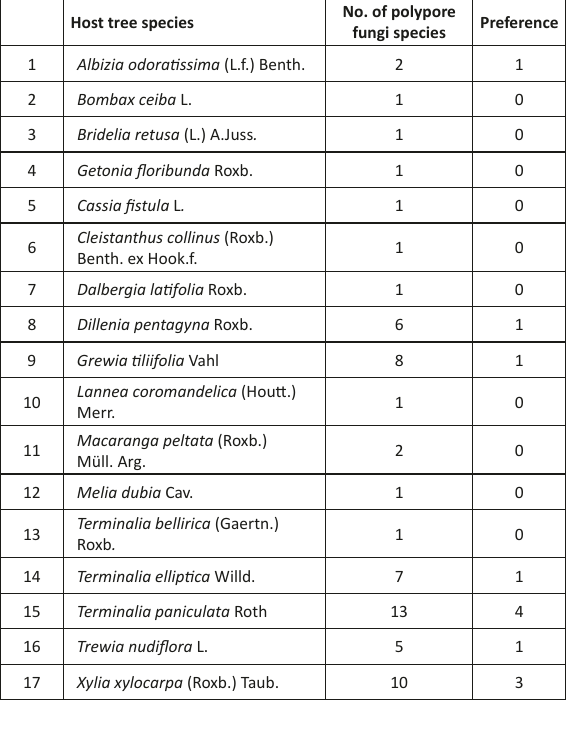
Table 1. Tree host species with number of polypore fungal species and number of fungi with preference for this host tree (>50% of occurrences on this host tree)